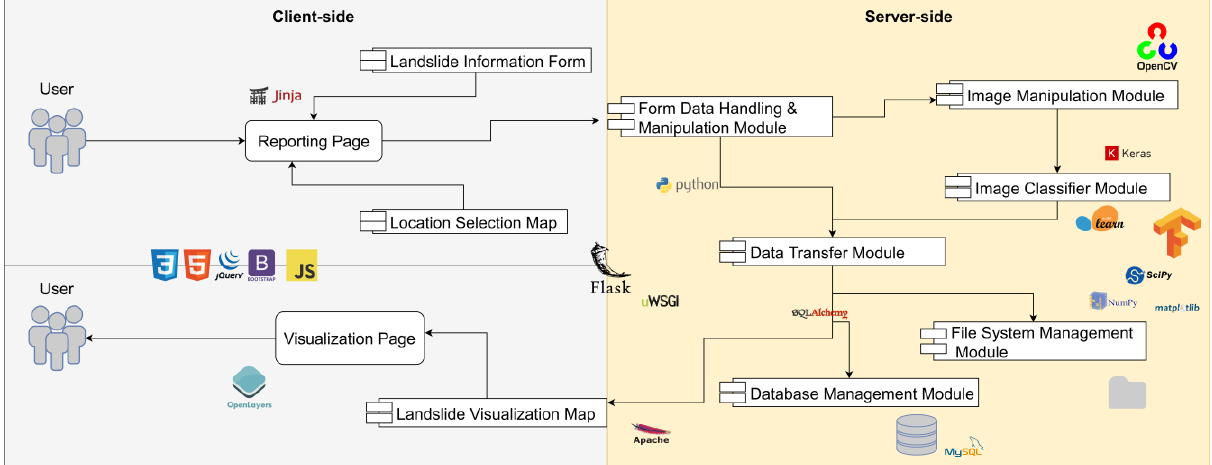
Figure 7. System components and their relationships, together with the technologies